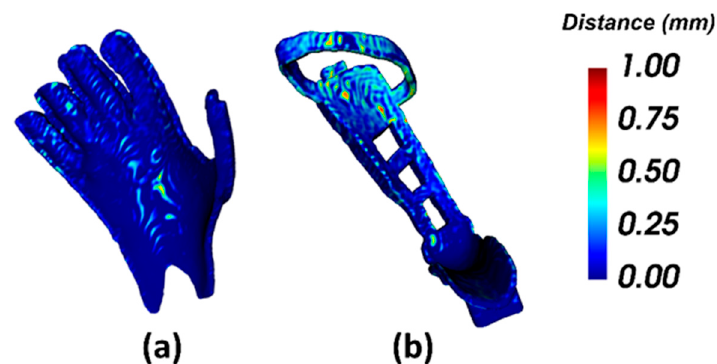
Figure 6. Distance comparison between the 3D models of the limb mold obtained from CT images before and after the sterilization process: ( a ) Case 1 hand mold; ( b ) case 2 foot mold.